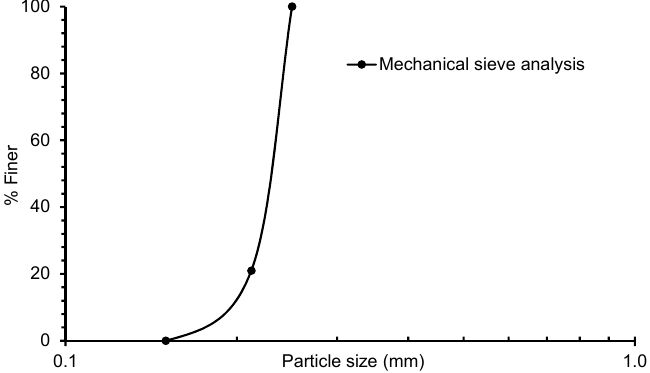
Figure 1. Initial particle size distributions from mechanical sieve analysis.